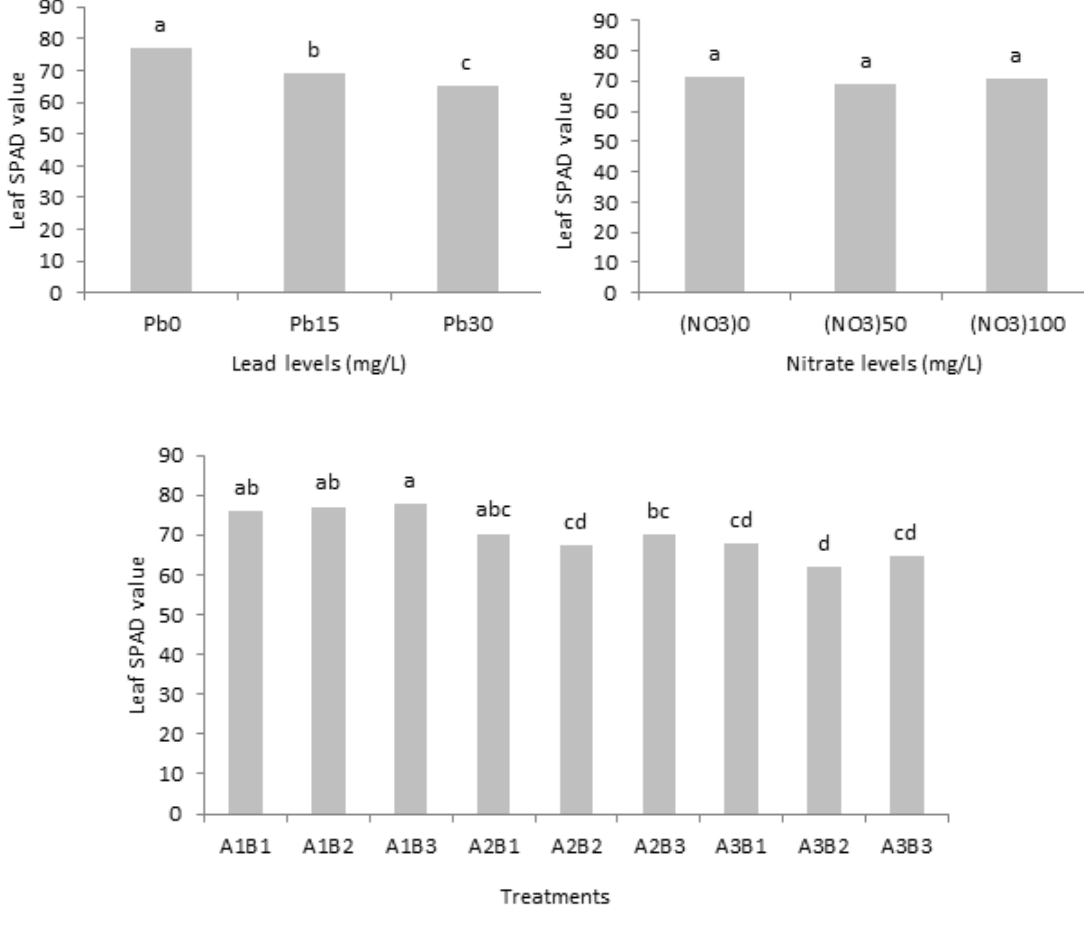
Figure 1: Leaf SPAD value of plants under lead and nitrate interaction treatments. Treatments indicate lead levels (A: 0, 15, 30 mgL -1 ) and nitrate levels (B: 0, 50, 100 mgL -1 ). Data are average of four replications ±SD. Comparison of means was done at 5% level of LSD